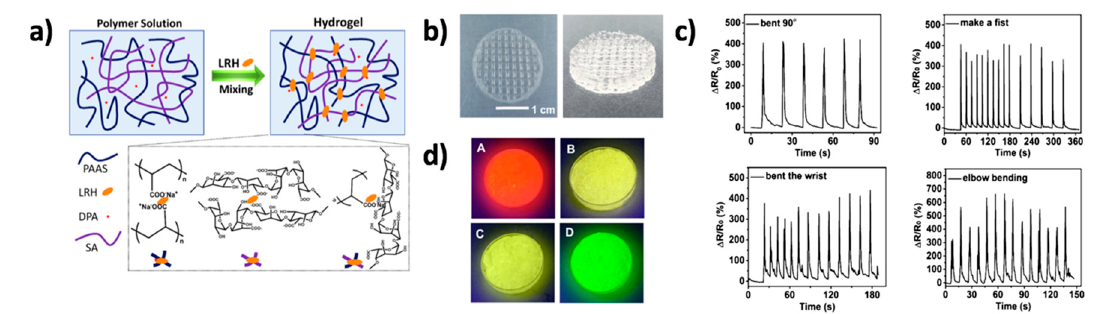
Figure 11. Skin-inspired multifunctional device. ( a ) Scheme of the preparation of SA/PAAS/LRH hydrogel. ( b ) Top and side photos of the printed hydrogel wafer with a grid structure. ( c ) Response to sensor strain. First row: Sensor attached on the forefinger of a human hand responding to bending angles from 0° to 90° (left); and sensor attached on the back of the hand responding when making a fist (right). Second row: Relative changes of the hydrogel films in sensing wrist bending (left); and